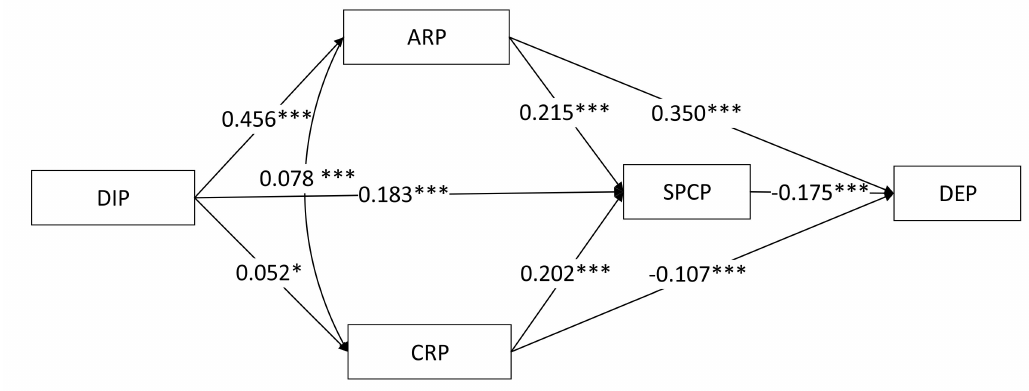
Figure 3. Results of structural equation modeling. Note: * p < 0.05, *** p <